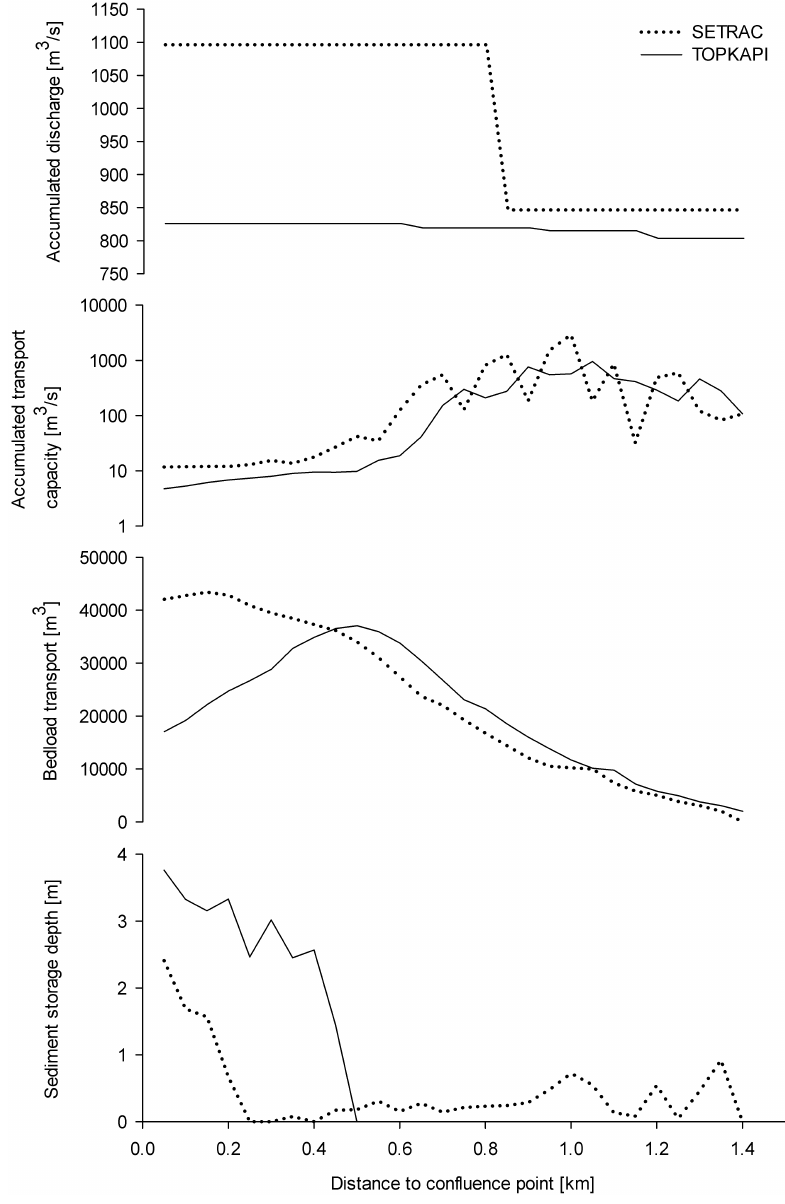
Fig. 7. Comparison of SETRAC and TOPKAPI for the tributary Spigge. A : Accumulated discharge over the simulation period for each cross- section element, B : accumulated transport capacity, C : bedload transport of each cross-section of the entire simulation period, D : sediment storage depth of the last time